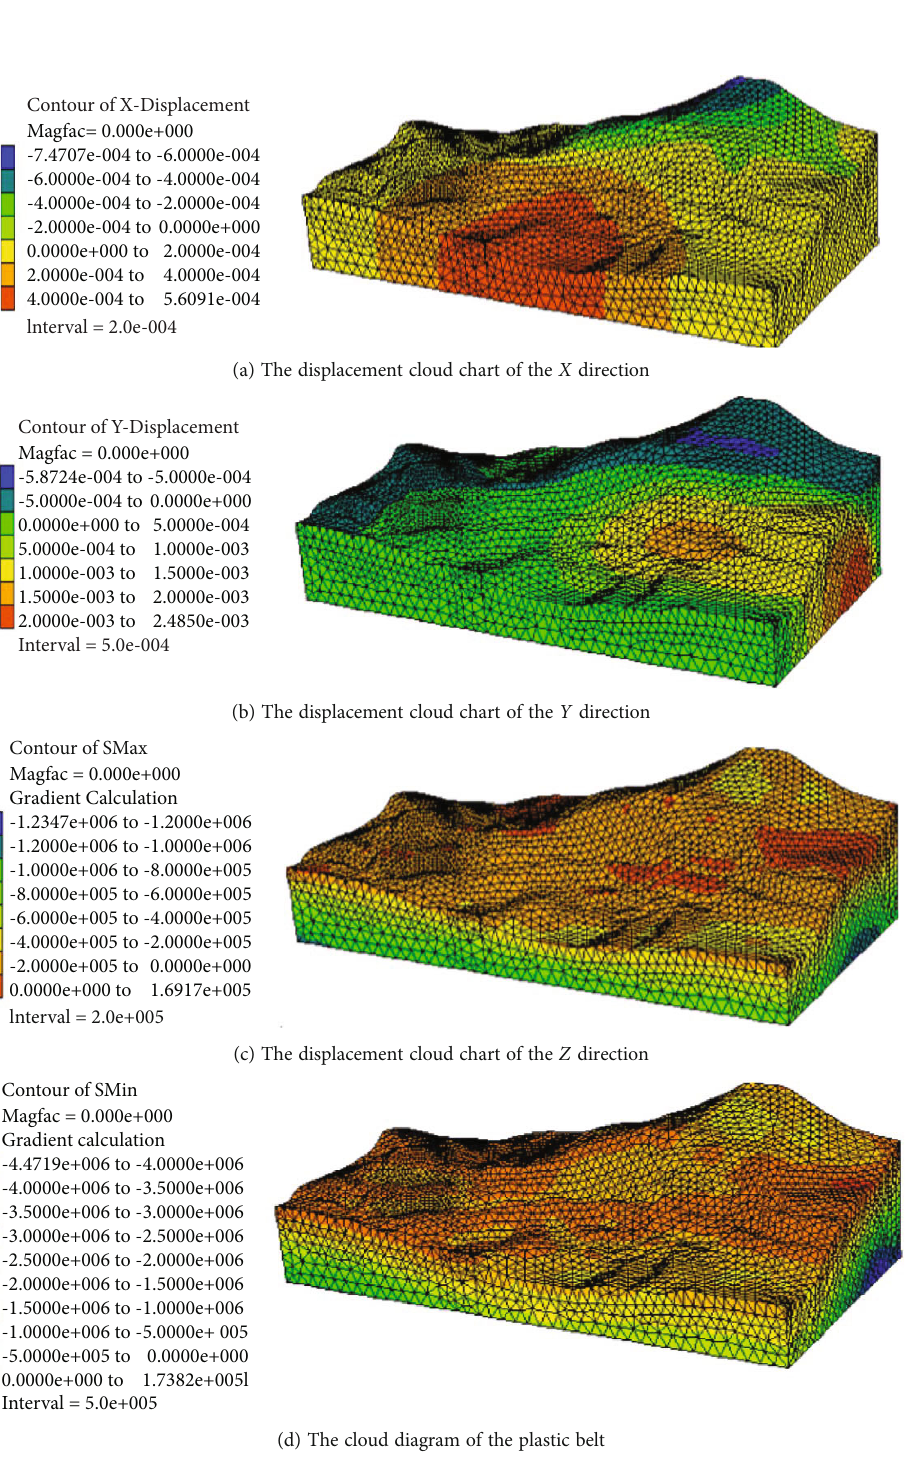
Figure 12: Displacement cloud chart and plastic zone of